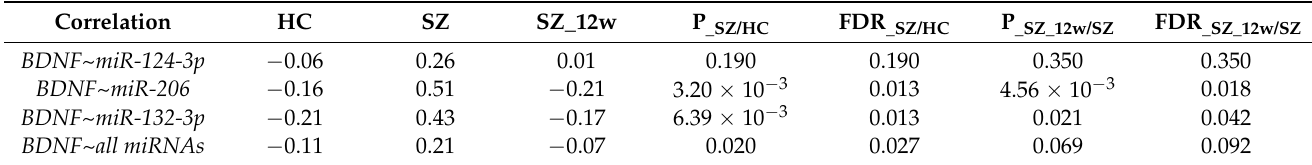
Table 4. Co-expression analysis in healthy controls and SZ patients before and after antipsychotic treatment.